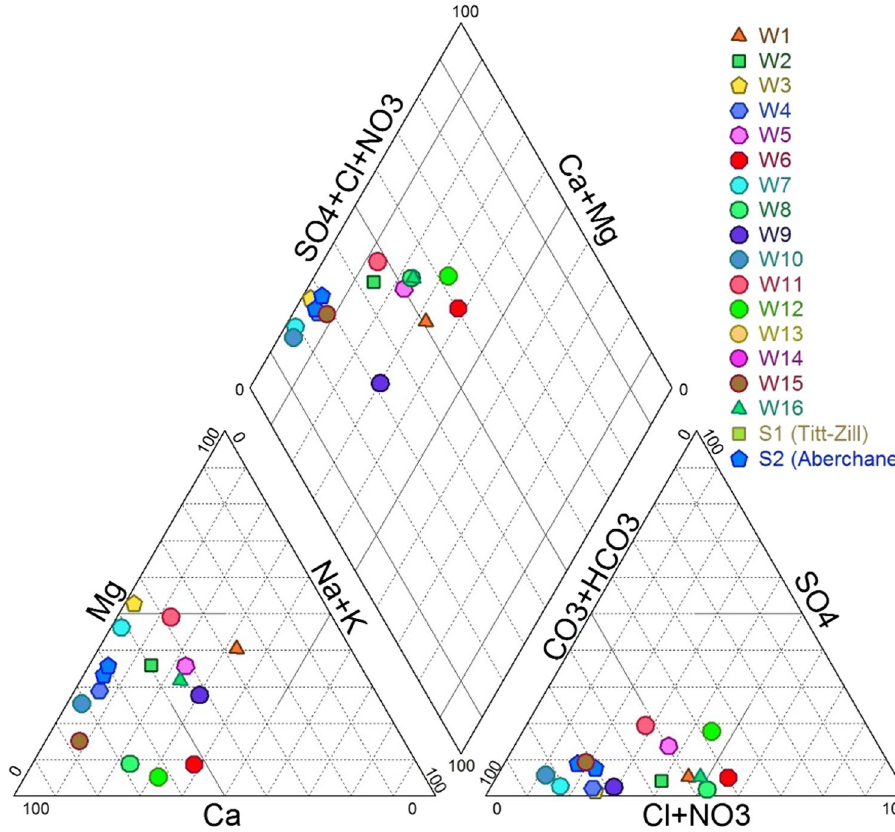
Fig. 4 Piper triangle diagram of groundwater in the study